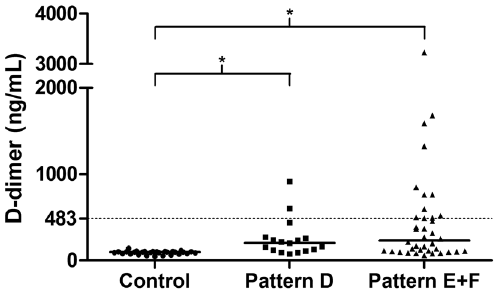
Figure 1. Plasma D-dimer levels in healthy control subjects (Control) and hepatosplenic schistosomiasis patients with either central fibrosis (Pattern D) or advanced periportal cirrhosis (Pattern E + F). The solid horizontal lines show D-dimer median values (96, 199 and 229 ng/mL), while the dashed line indicates the cut-off value for hyperfibrinolysis [14]. *p , 0.001; Kruskal-Wallis